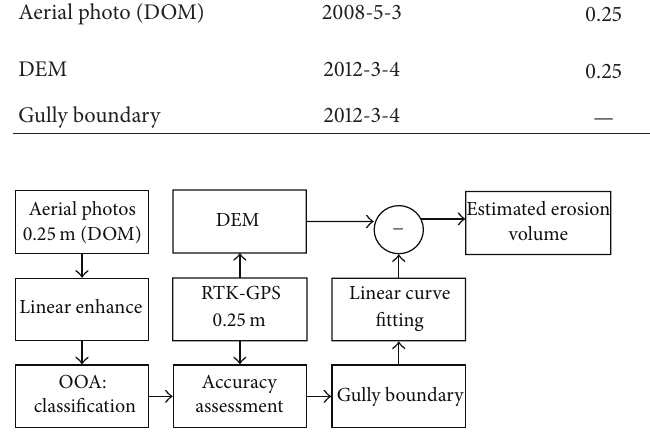
Figure 4: Flow chart showing the data and procedures followed for the